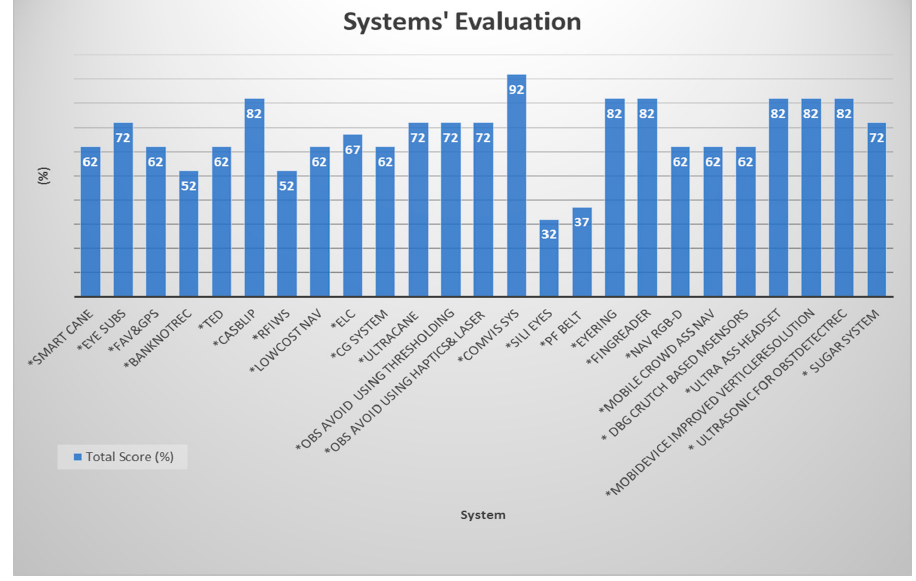
Figure 42. Systems’ evaluation presents the total score for each system.